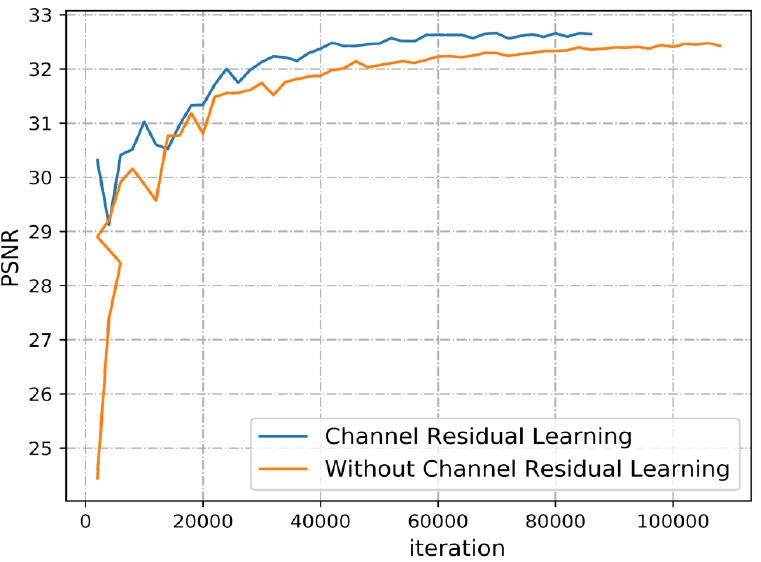
Figure 10. Results of ablation experiments about channel residual